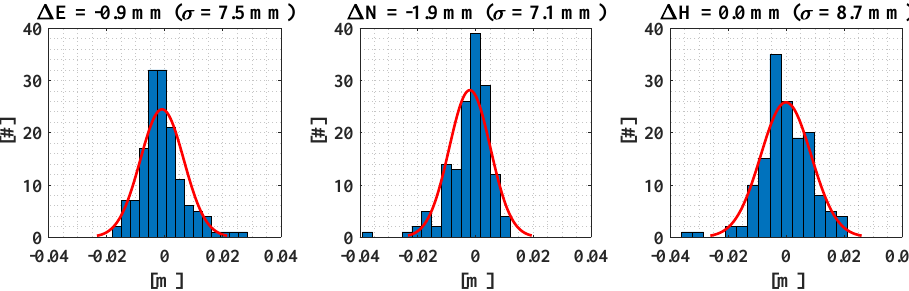
Figure 16. Point-based evaluation of the mobile laser scanning system for east, north, and height component. A total number of 148 target scans were compared to the reference values. The mean values ∆ E , ∆ N , and ∆ H as well as the standard deviations σ are stated on top of the